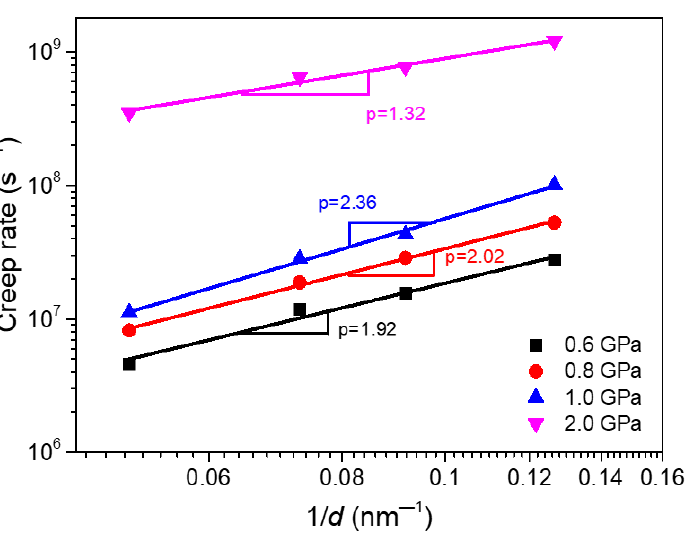
Figure 7. The relationship between the creep strain rate and the reciprocal of grain size d of the segregated Ni-Mo (3 at.%) sample at 1100 K under different applied stresses.